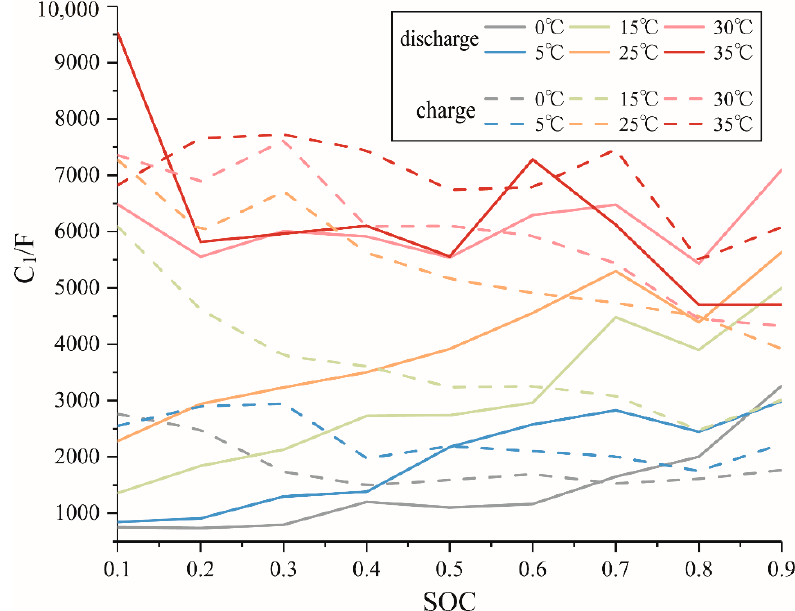
Figure 13. Evolution of the CPE capacitance C 1 as a function of SOC at different temperatures in the range 0–35 °C.